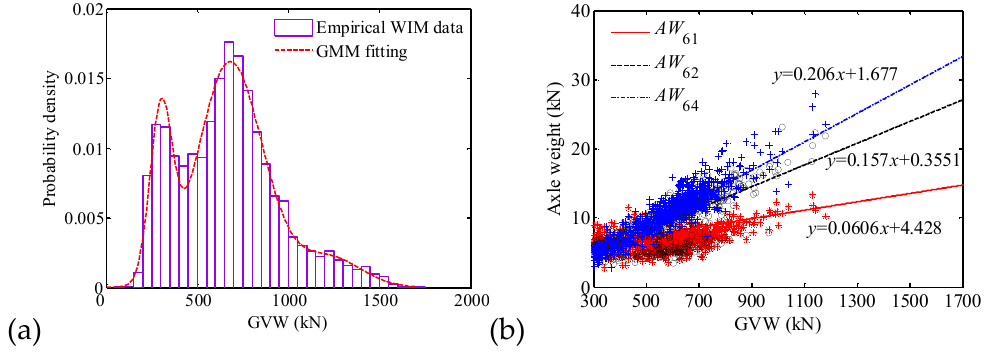
Figure 9. Probability distribution of V6 trucks: ( a ) PDF of GVWs; ( b ) relation between the GVW and the axle weight.